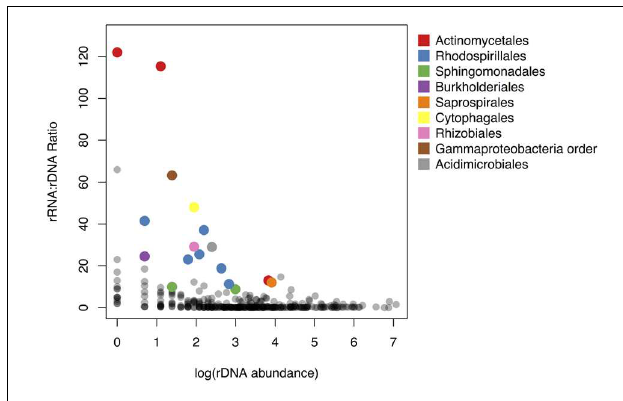
FIGURE 3 | Relationship between rRNA: rDNA ratio and abundance in the rDNA community. rRNA: rDNA ratio is analogous to the activity intensity parameter ( m(k) ) in the sampling model. Colored points represent taxa significantly overrepresented in the active community. Points are colored by taxonomic order.